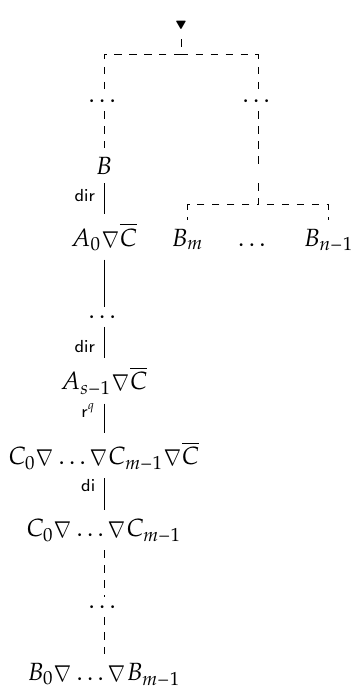
Figure 17. Theorem 5: Finishing